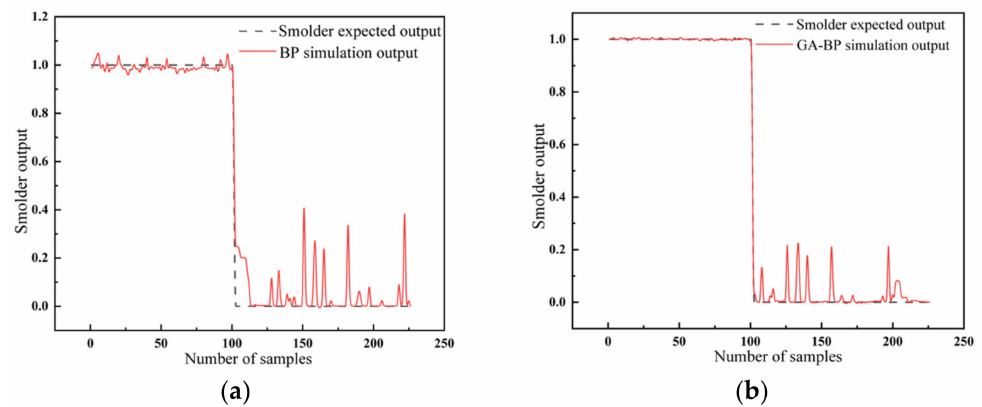
Figure 10. The output results of smolder with ( a ) the BPNN and ( b ) the